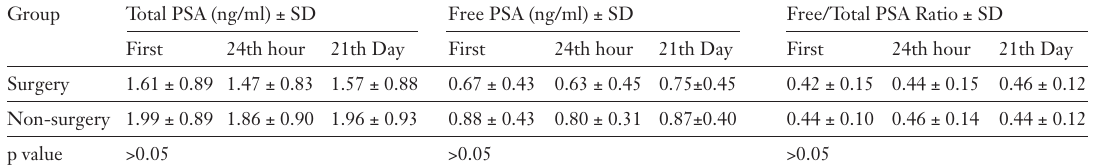
Table 2. Summary of the total PSA, the free PSA values and the f/t PSA ratios of the patients grouped ac- cording to operation